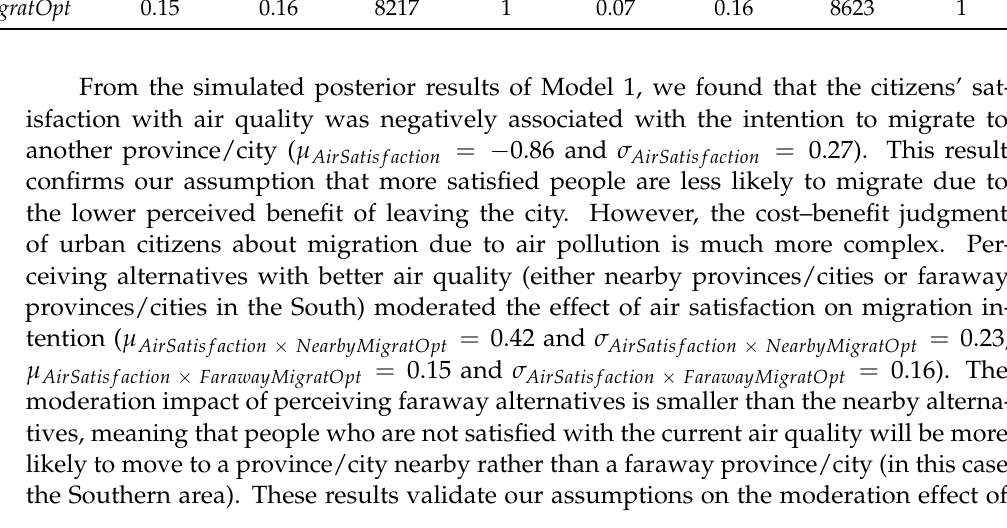
Table 2. Model 1 ′ s simulated posteriors.